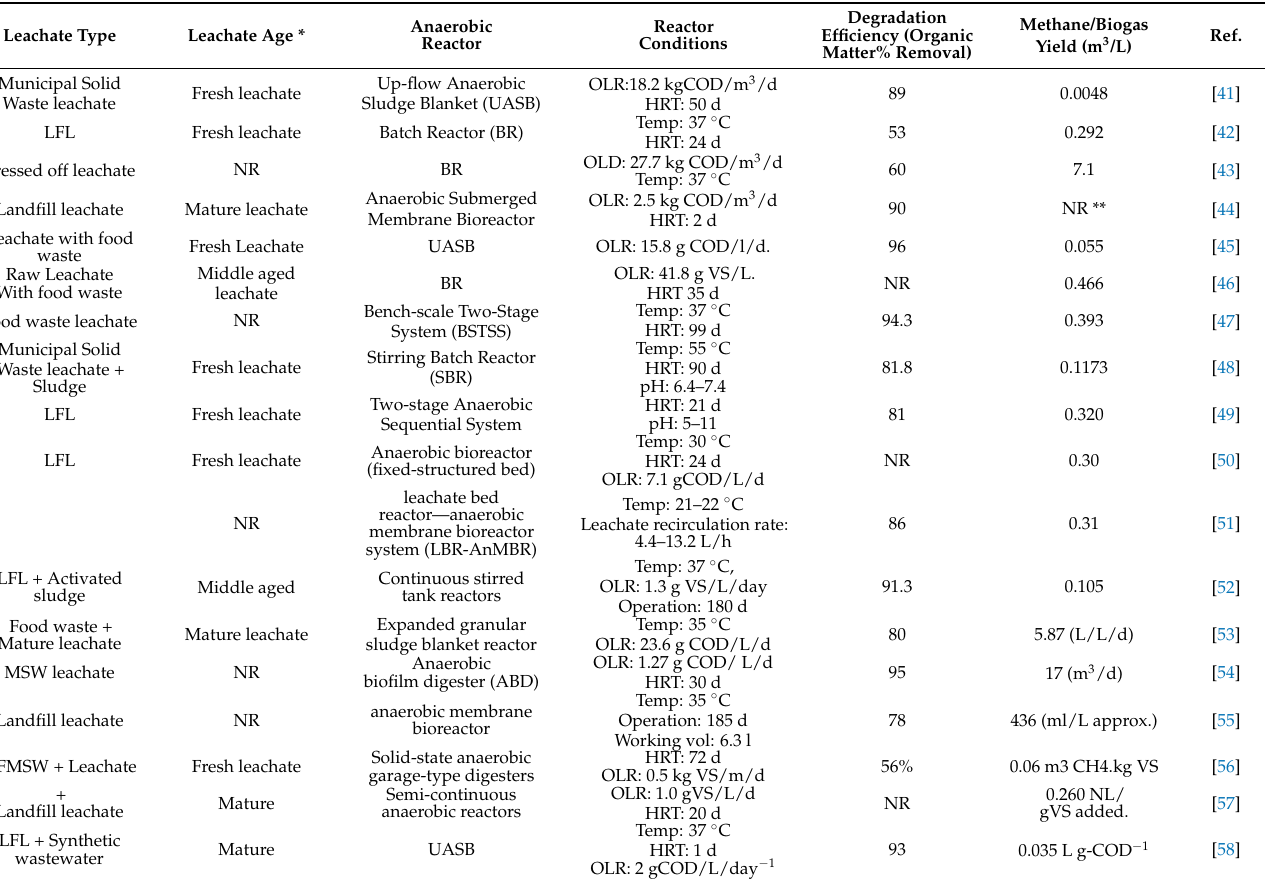
Table 2. Anaerobic digestibility of leachate, degradation potential, and methane